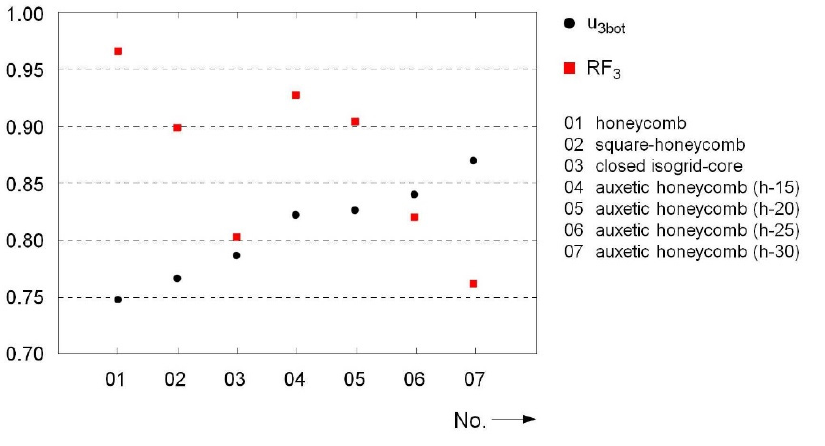
Figure 19. Honeycomb cores: normalized maximum values for displacement u 3,bot and reaction force RF 3 .